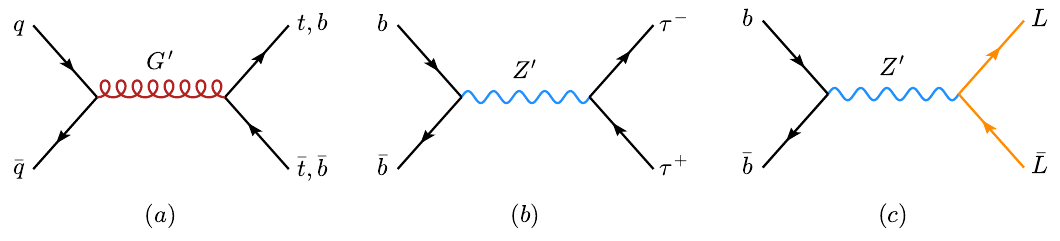
Figure 14 . Feynman diagrams describing the main processes for G 0 , Z 0 , and vector-like lepton production at the